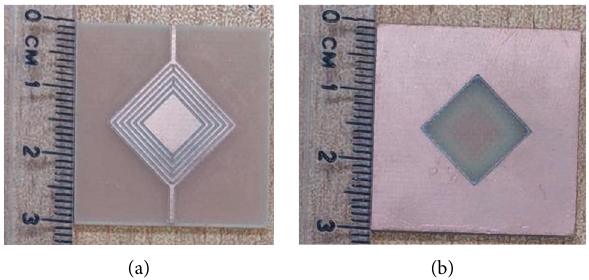
Figure 8: Photograph of the fabricated prototype: (a) top view; (b) bottom view.